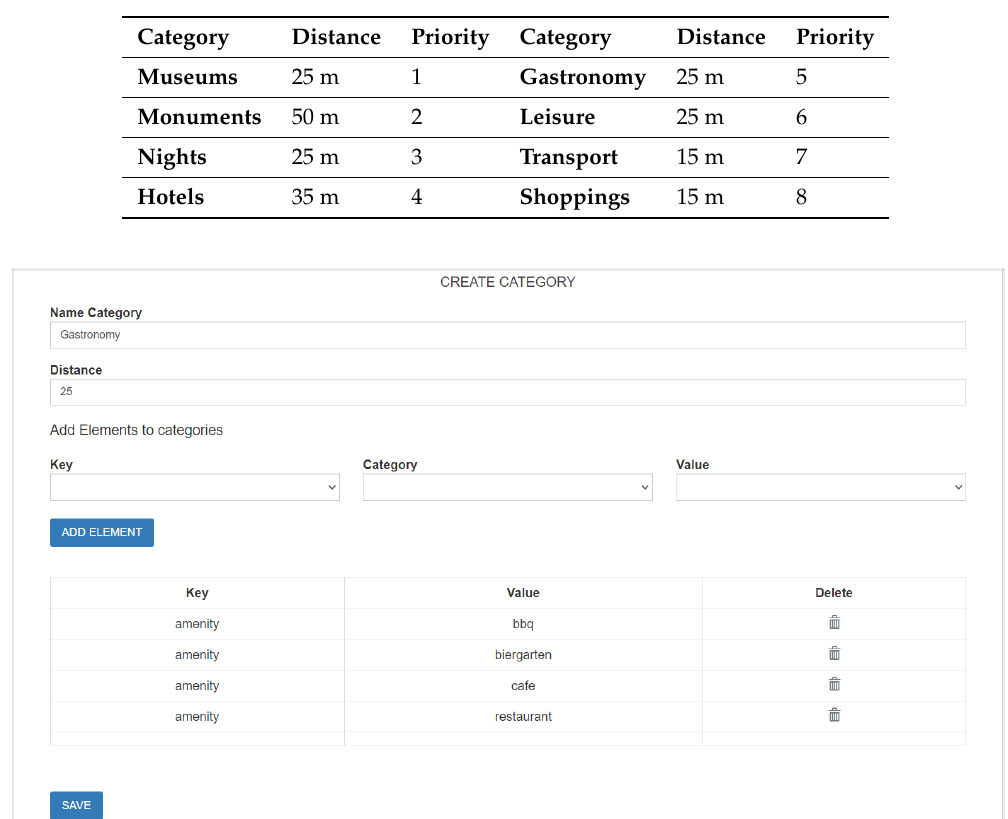
Table 3. Example of priorities and distances used by categories.